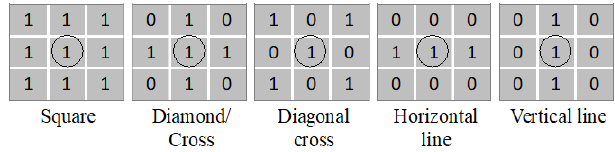
Figure 2. Basic structuring elements for binary image processing